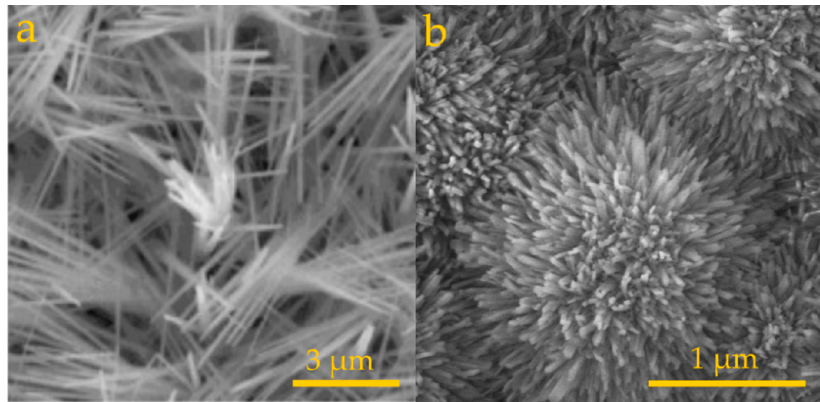
Figure 1. FE-SEM images of nanostructured oxides formed by copper passivation in 1.0 M NaOH ( a ) ( − 200 mV vs. Ag|AgCl, 10 min) [49] and 0.1 M NH 4 HCO 3 ( b ) ( − 200 mV vs. Ag|AgCl, 14 h; unpublished results by A. Brudzisz, D Gizi ń ski, W.J. St ę pniowski et al . ). Figure 1a has been reproduced from [49] ® 2019 Elsevier.